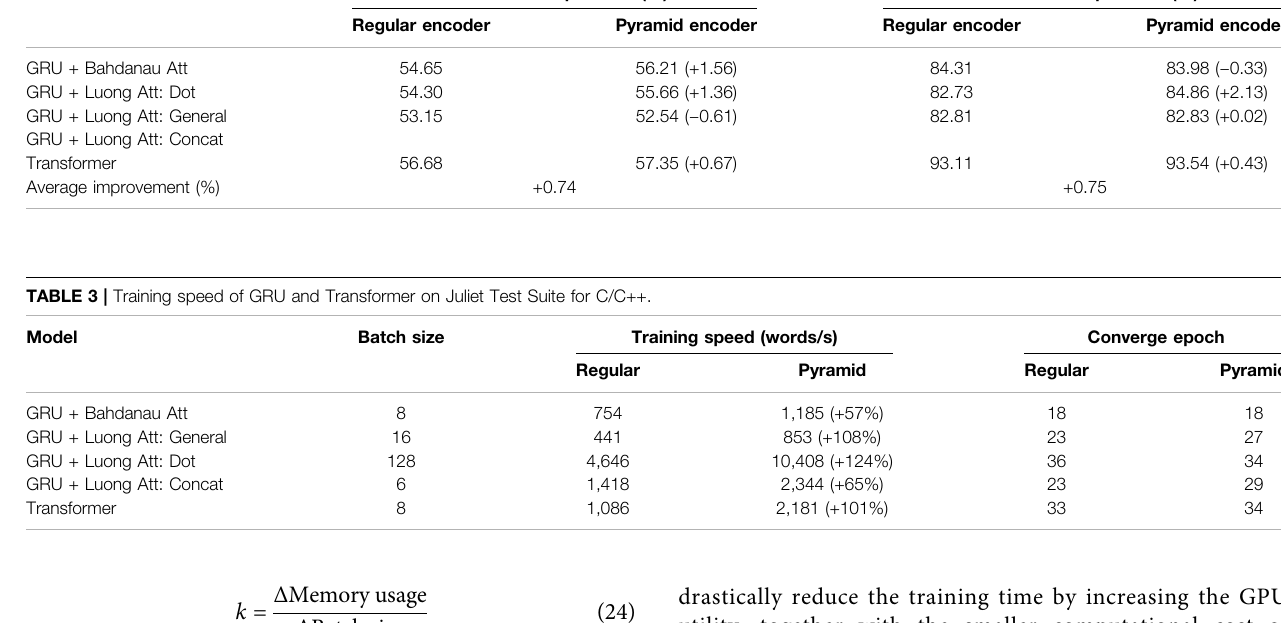
TABLE 2 | Repair rate of GRU and Transformer on Juliet Test Suite for Java, comparing the regular encoder and pyramid encoder. We did not include result from DeepFix, because the provided data tokenizer only support C/C++. Model